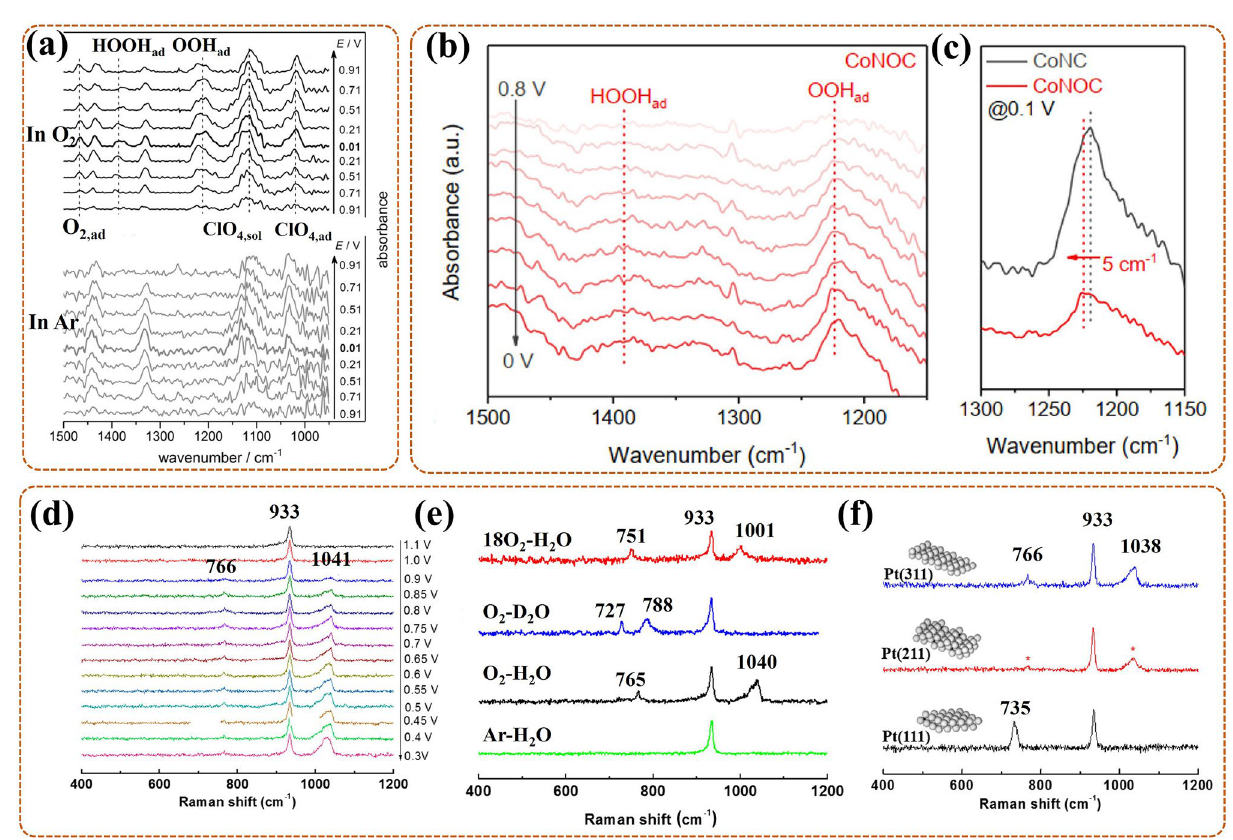
Fig. 9 a In-situ IR spectra of Pt/C in 0.1 M HClO 4 in O 2 and in Ar [93]; Reused with approval; Copyright 2018 WILEY-VCH Verbg GmbH&Co. KGaA, Weinheim. b In-situ ATR-IR spectrum of CoNOC in 0.1 M HClO 4 with O 2 saturated; c The comparative spectrum of CoNOC and CoNC in the band near 1220 cm −1 [128]. Reused with approval; Copyright 2021 American Chemical Society. d In-situ SHIN- ERS spectrum of Pt (311) in 0.1 M HClO 4 with O 2 saturated; e The isotopic control spectra on the Pt (311) surface, at 0.7 V, in aqueous with 18 O 2 (red curve), in deuterated 0.1 M HClO 4 (blue curve); f In-situ SHINERS spectra of different Pt (hkl) surfaces at 0.8 V [129]; Reused with approval; Copyright 2020 American Chemical Society. (Color figure